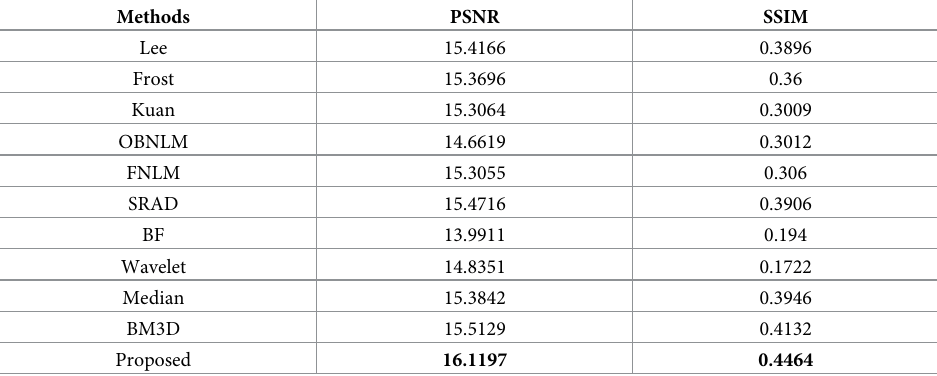
Table 2. Denoising PSNR and SSIM values of each method are relative to the simulation